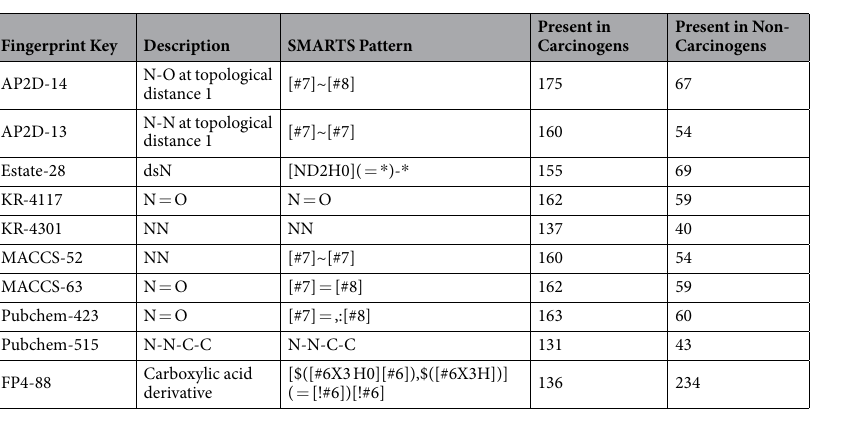
Table 5. Top ranking substructures and their corresponding description and the number of occurrence in carcinogens and